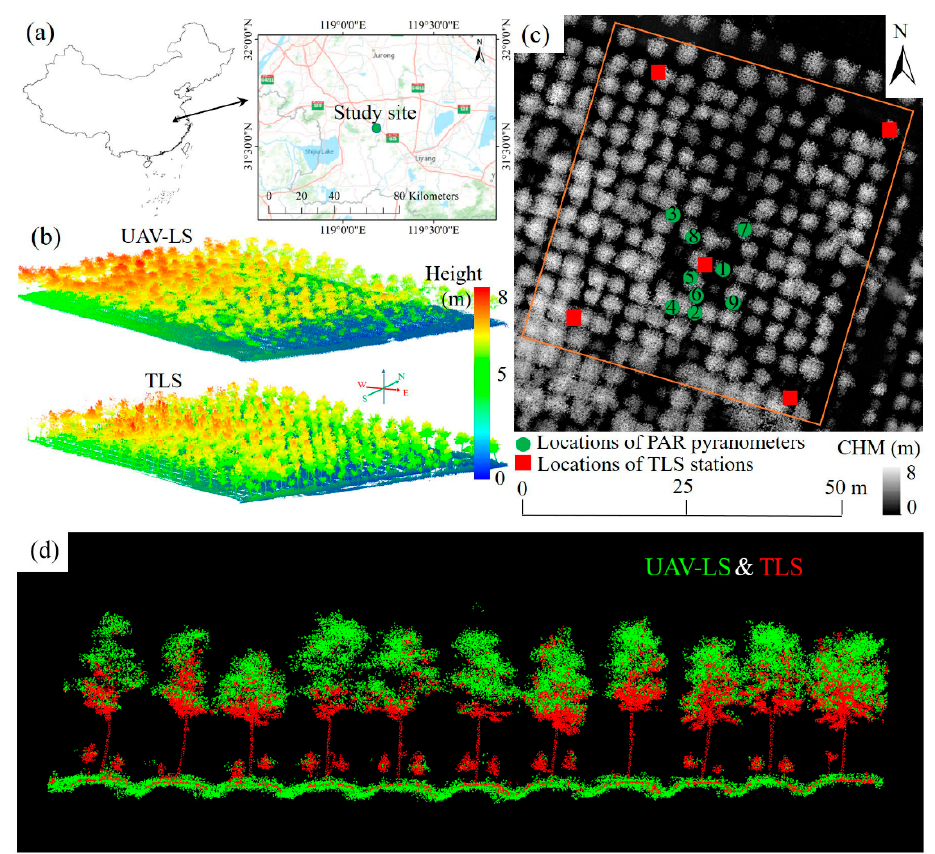
Figure 1. The study site location (inset a ) and corresponding unmanned aerial vehicle based laser scanning (UAV-LS) and terrestrial laser (TLS) point cloud data (inset b ). The inset ( c ) shows the field setup locations of the TLS system and nine photosynthetically active radiation (PAR) pyranometers. The vertical profile and coverage of the fused point cloud resulted from TLS (red) and UAV-LS (green) point clouds (inset d ).